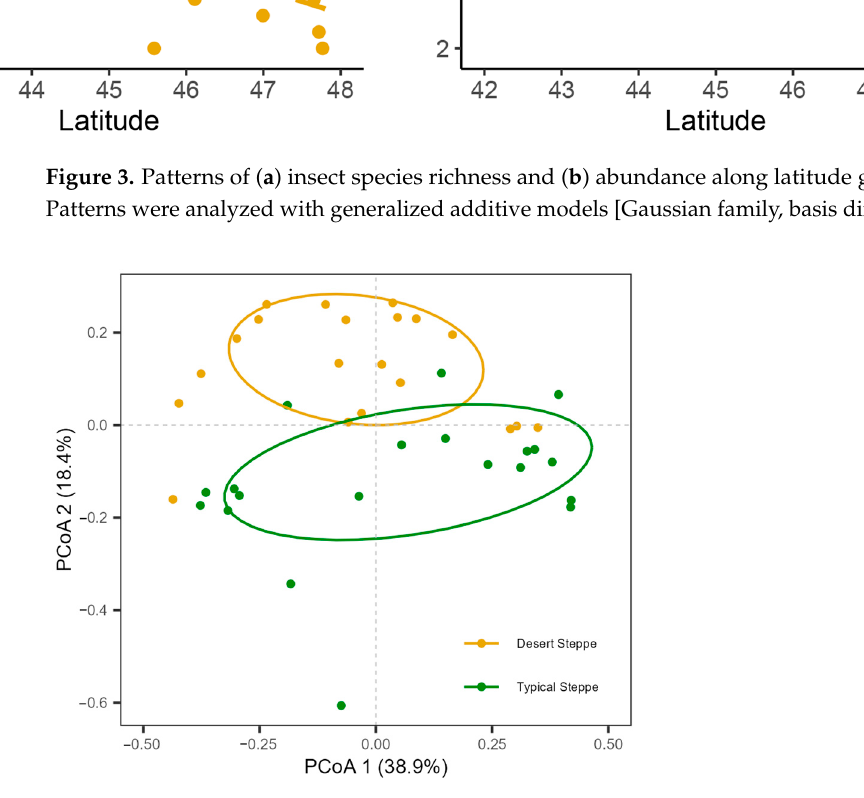
Figure 4. Principal coordinate analysis (PCoA) of insect communities across different grasslands. PCoA was generated using the Bray–Curtis dissimilarity method.